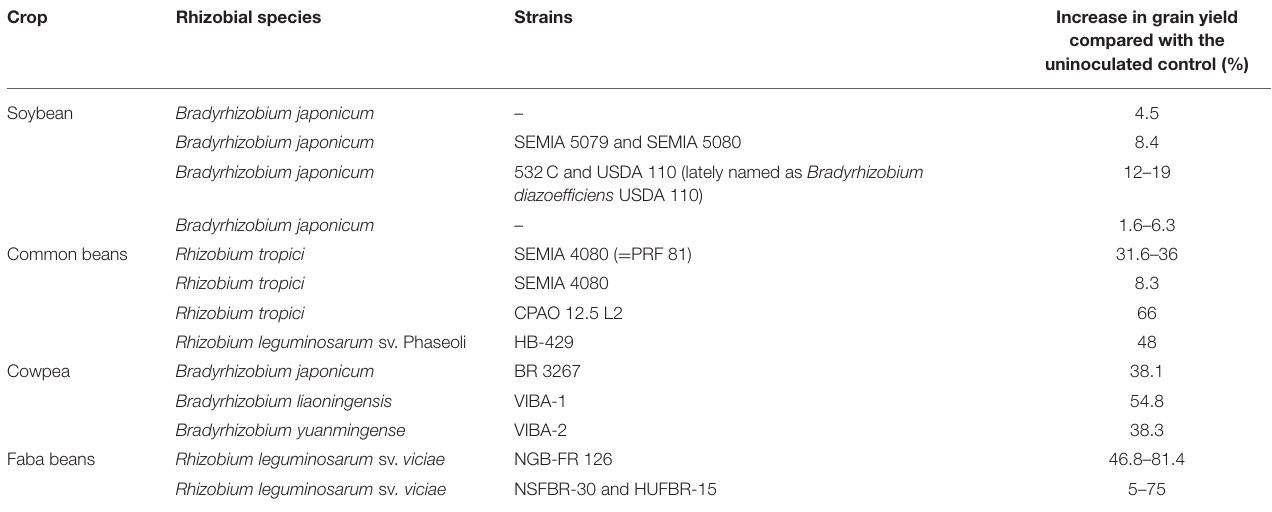
TABLE 2 | An increase in grain yield of different legume species due to inoculation with specific rhizobial strains. Crop Rhizobial species Strains Increase in grain yield